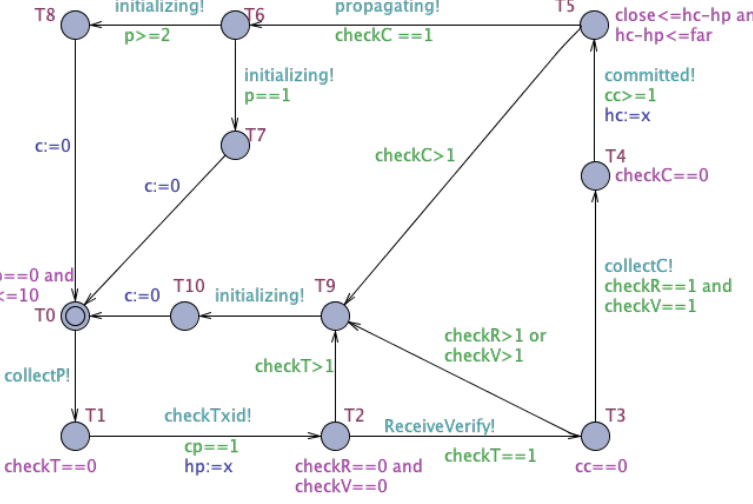
Figure 3. The two-step